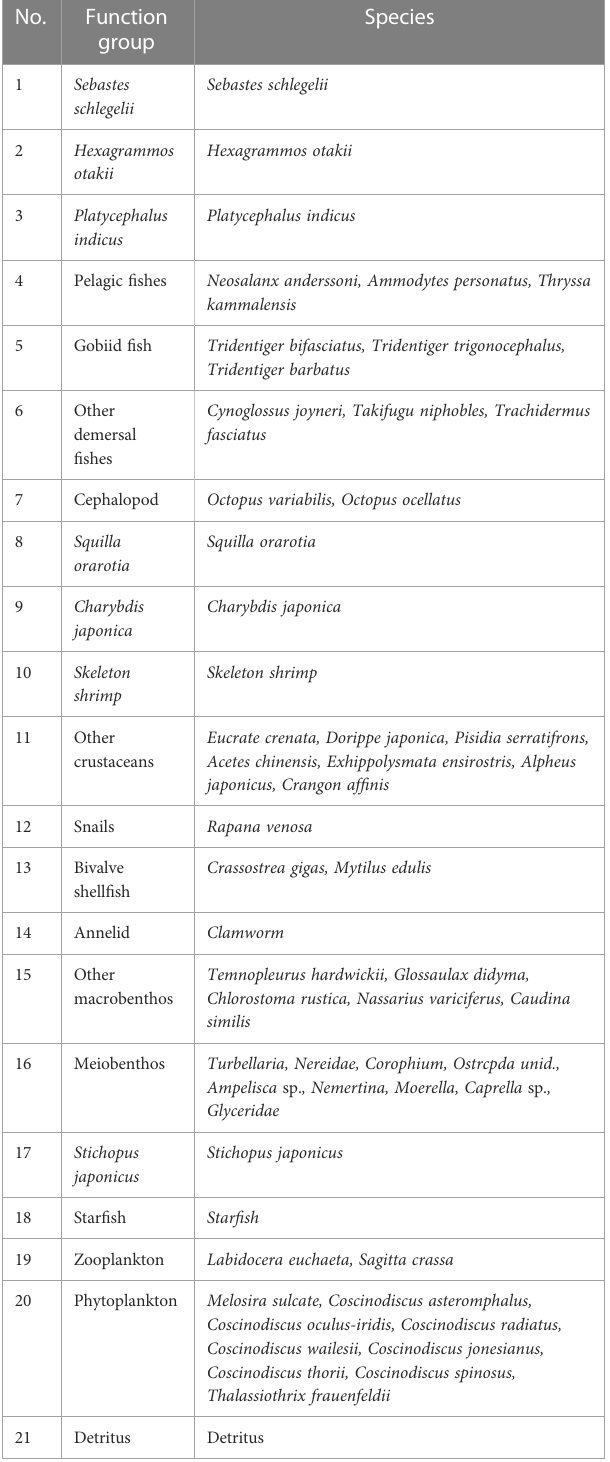
TABLE 1 Division of functional groups and their species composition in the study marine ranching ecosystem model in Bohai Bay, China.